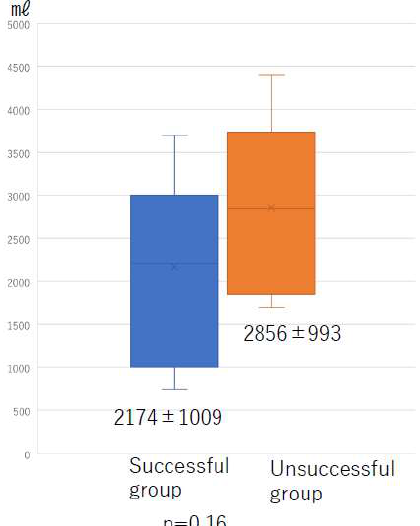
Figure 9. Total amount of fat removed according to whether liposuction was successful or unsuccessful.